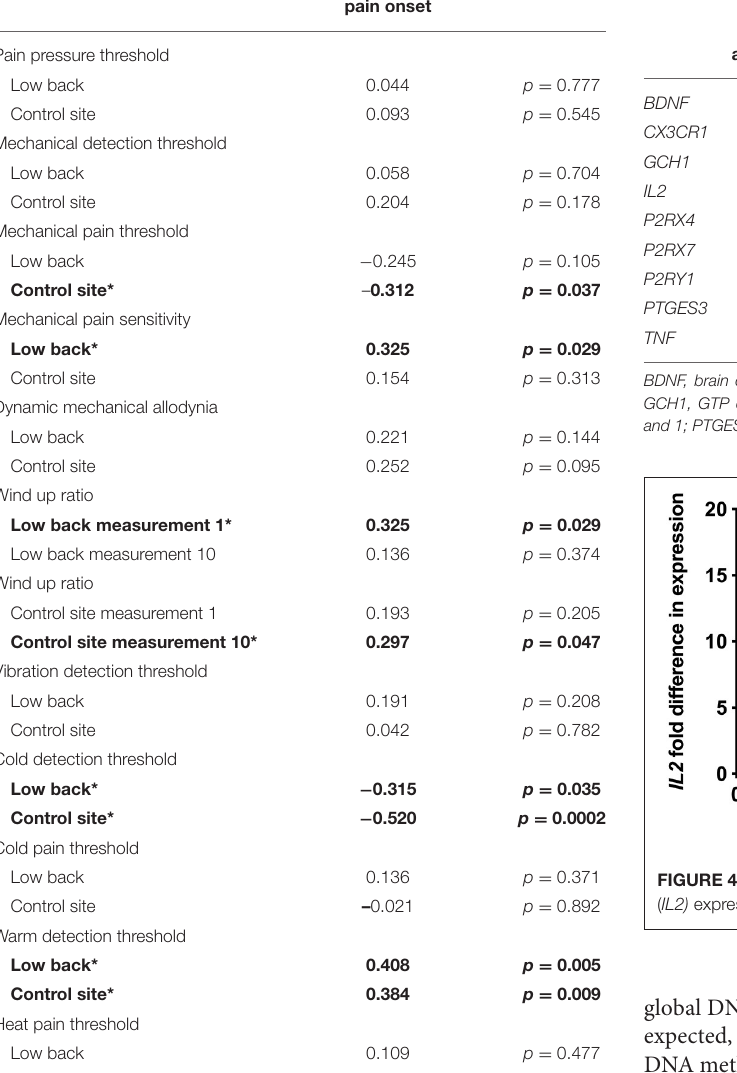
TABLE 6 | Significant correlations of global DNA methylation with mRNA expression of pain-related genes. p -value cLBP 6 month Gene Correlation visit correlation with global with global DNA DNA methylation at methylation at pain onset